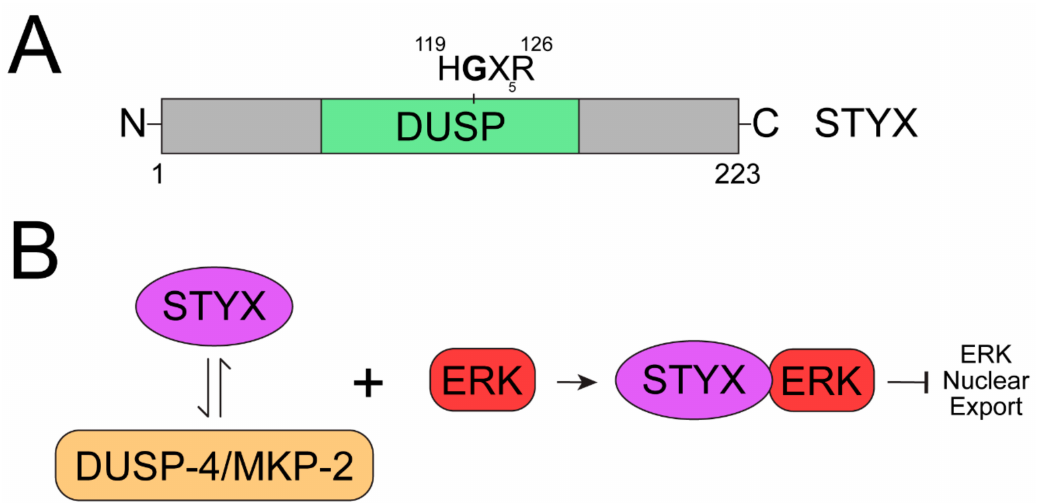
Figure 4. Pseudophosphatase STYX regulates ERK1/2 activity. ( A ) Schematic diagram of the pseudophosphatase STYX. STYX has a DUSP domain, which is catalytically inactive due to a C120G mutation in the active site motif (HCX 5 R). ( B ) De- spite lacking catalytic activity and a CH2 domain, STYX competes with DUSP-4/MKP-2 to regulate the nucleocytoplasmic shuttling of ERK1/2. STYX binds ERK and serves as a nuclear anchor, inhibiting the nuclear export of